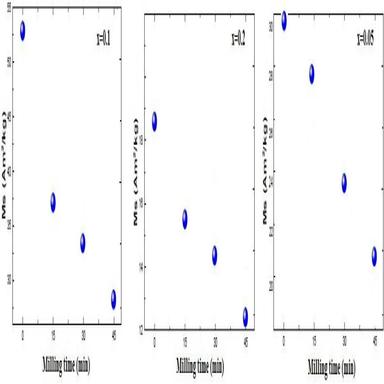
Mass magnetization versus various milling durations for samples with Co content from 0.05 to 0.2.